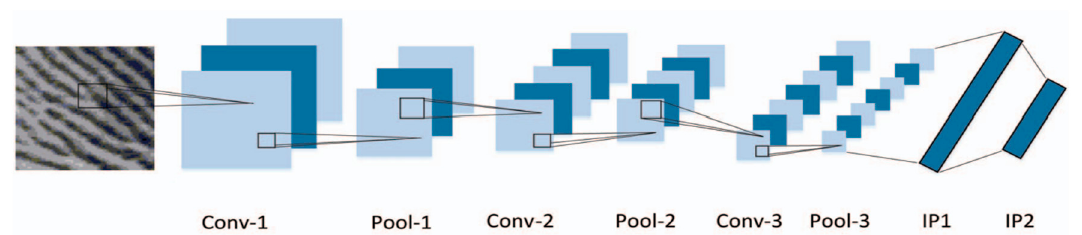
Figure 10. JudgeNet and LocalNet share a similar convolutional architecture